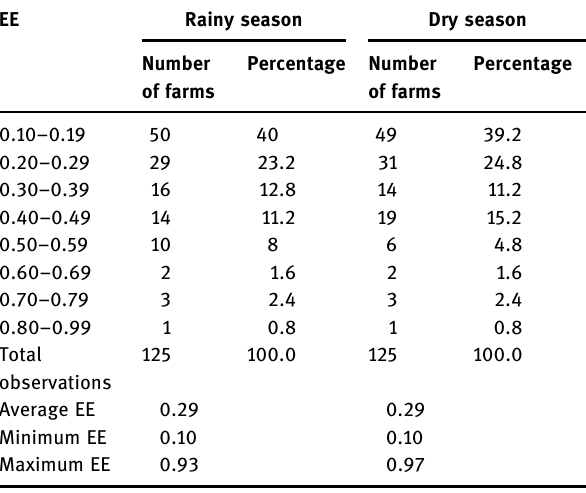
Table 5: Distribution of estimates of economic e ffi ciency ( EE ) for rice